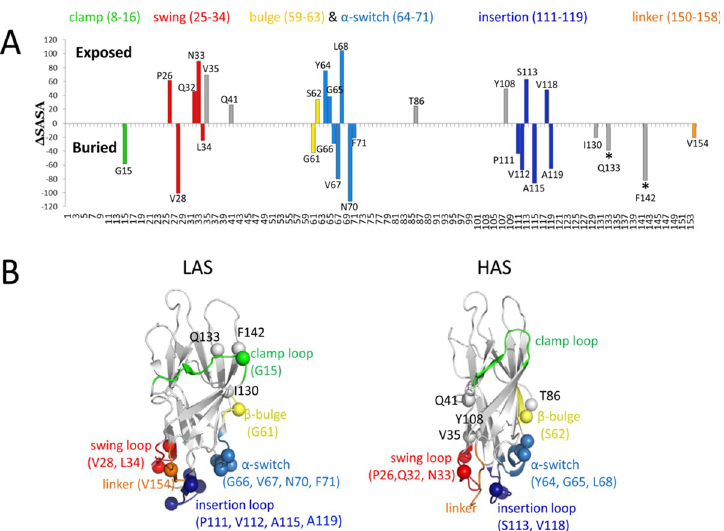
Fig 7. Residues undergo changes in solvent-accessible surface area (SASA) between LAS and HAS of FimH. (A) The difference in solvent-exposed surface area ( Δ SASA) calculated individually for each residue using LAS and HAS conformers of FimH (PDB code 4xo9 and 4xo8, respectively). FimH residues whose SASA changed by 2-fold and at least 20 Å 2 are shown. The regions that exhibit substantial conformational differences in atomic-level structures of FimH LD LAS and HAS [2,3] are color-coded in Panels A and B. Mannose-contacting residues are marked by asterisks. (B) C α atoms of FimH LD residues highlighted in Panel A are shown as spheres on LAS and HAS structures. Residues that transition from exposed-to-buried (downward-facing bars in Panel A) are mapped on the LAS conformer (PDB code 4xo9) and those that go from buried to exposed (upward-facing bars in Panel A) are mapped on the HAS structure (PDB code